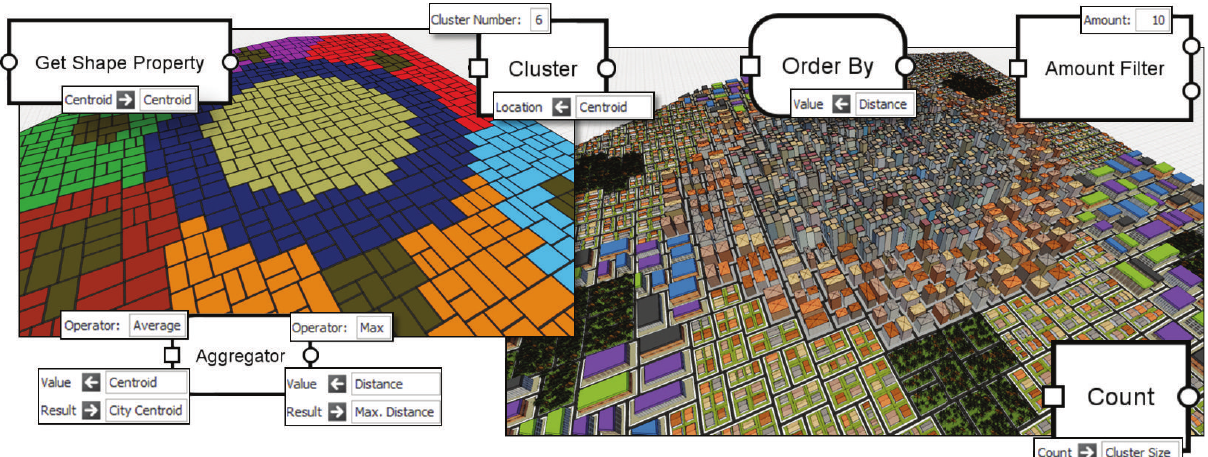
Figure7:Organizationofcityblocksforconstruction.Afterrandomlygeneratingaboutathousandcityblocks,thecitycenterwasdetermined in order to build a downtown area, a surrounding commercial area, and a peripheral area. The latter was divided into 6 clusters to define alternating industrial and residential neighborhoods. Again, the center point of each cluster was then calculated and the 10 closest blocks were reserved for green areas. This process involved several aggregation, sorting, clustering, grouping, and filtering operations.